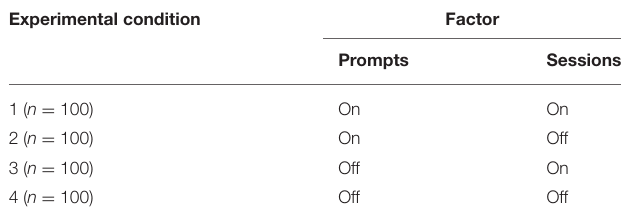
TABLE 1 | 2 × 2 factorial N =